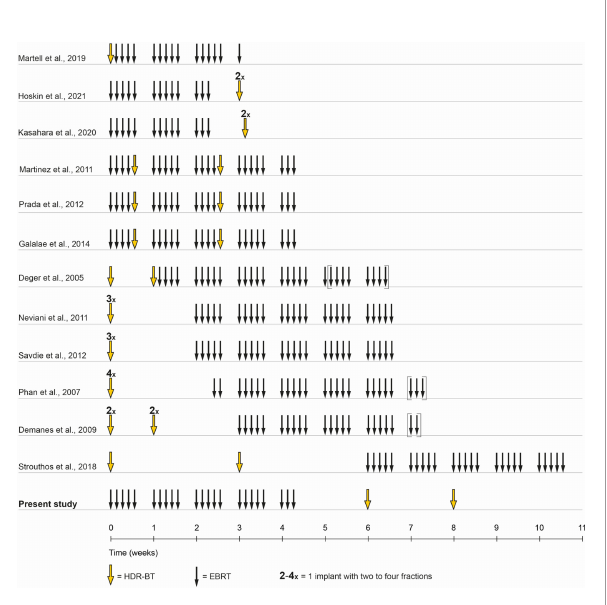
FIGURE 1 | Treatment schedule comparison. Shown is a comparison of timelines of combined EBRT and HDR-BT boost in the literature. In the present study, a treatment schedule with EBRT and two implants, two fractions HDR-BT boost was chosen. EBRT was administered in 4.5 weeks in 23 fractions of each 2 Gy. The fi rst HDR-BT boost fraction with 9 Gy was applied one to two weeks after the end of EBRT with the second fraction following two weeks